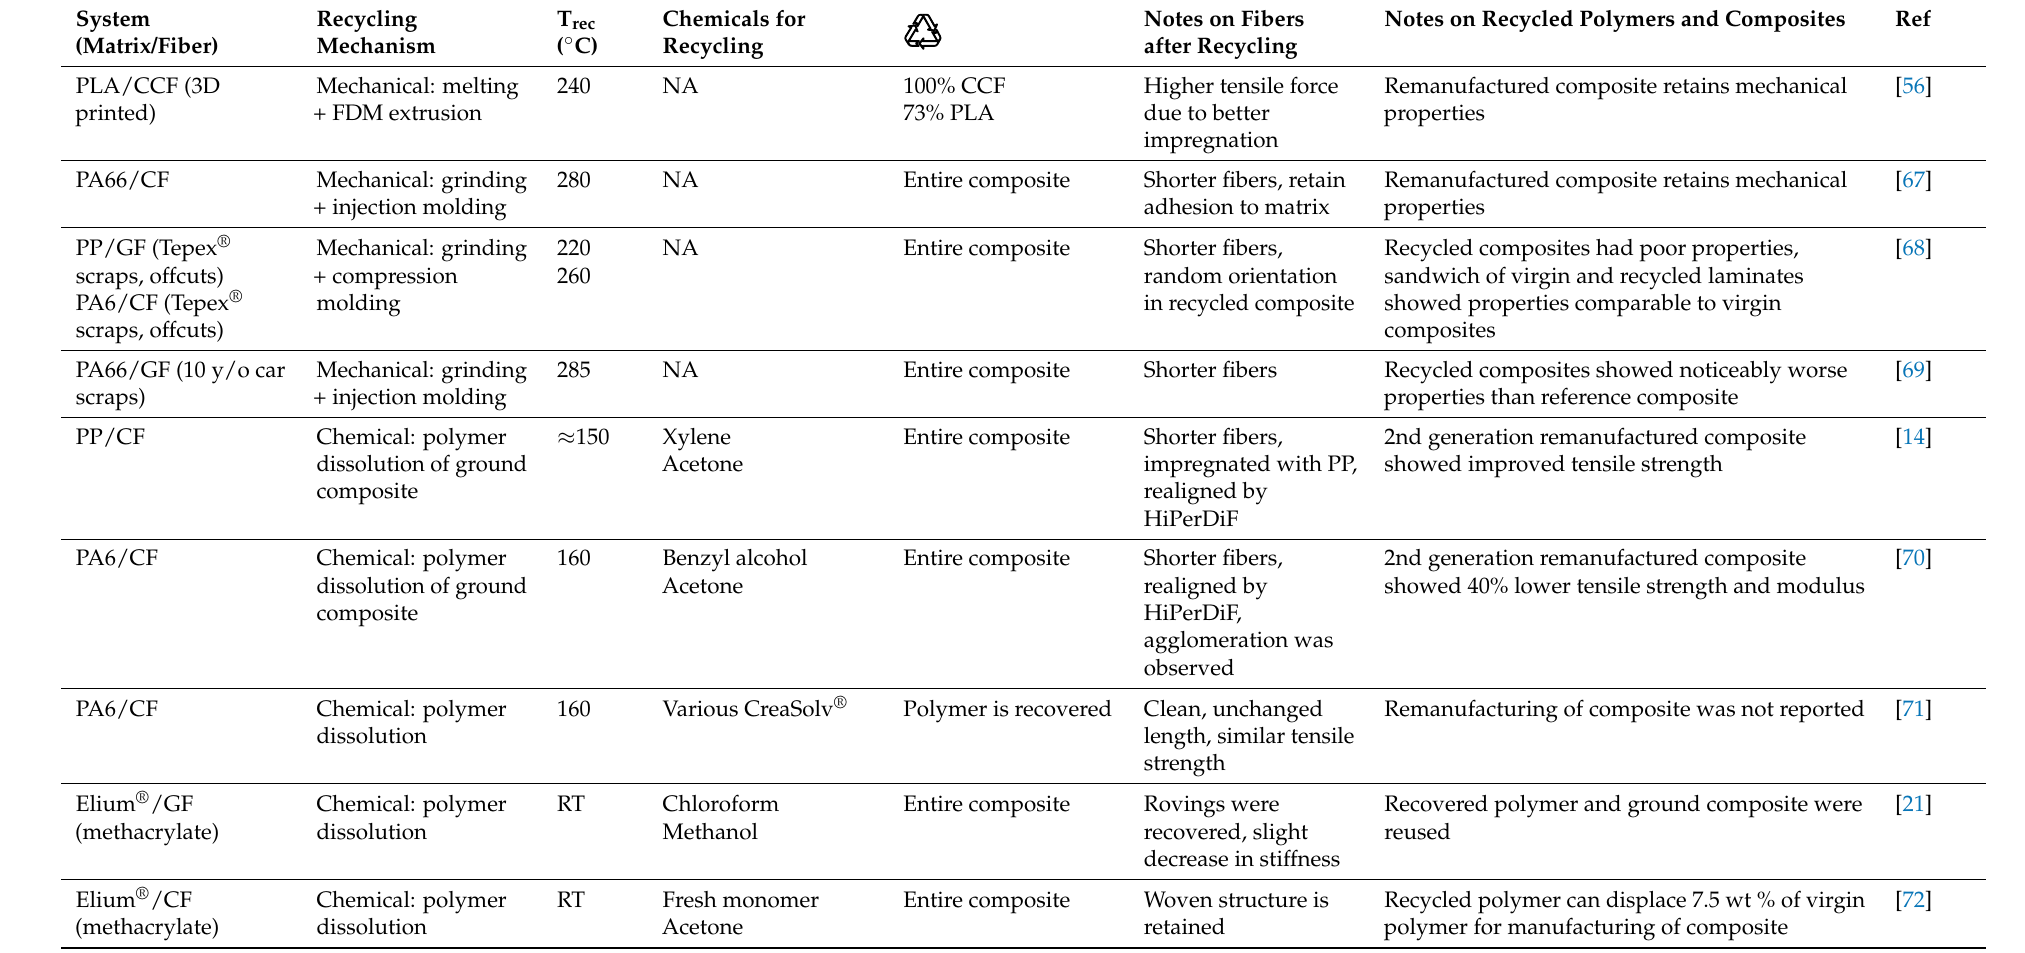
Table 2. Summary of reviewed works on the full recycling of TPFRPs, methodologies in use, and recycling outcome.